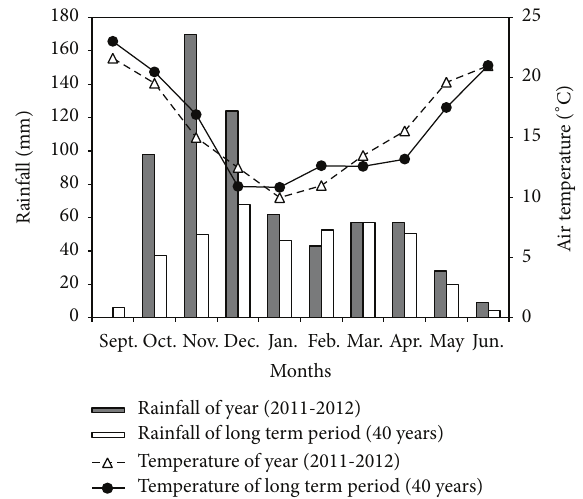
Figure 1: Monthly average of rainfall and temperature (2011-2012) at Merchouch compared to monthly values of a long term period